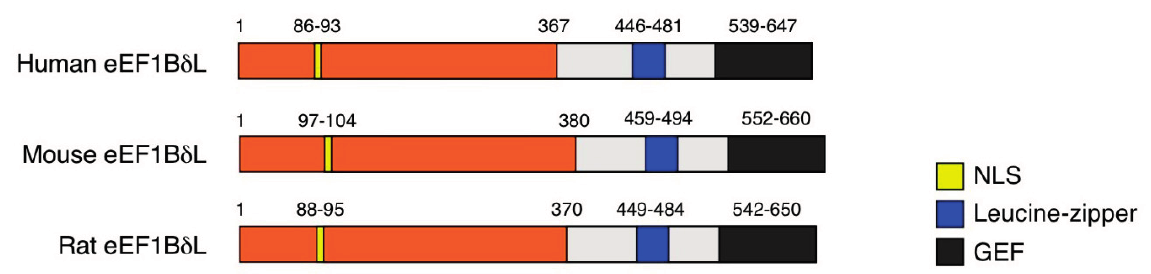
Figure 1. Schematic illustration of the EEF1D gene and protein products. Short- or long-isoform eEF1B δ mRNA is expressed, depending on whether exon III is skipped. eEF1B δ functions as a guanine nucleotide exchange factor for eEF1A and has a crucial role in translation fidelity; eEF1B δ L functions as a transcription factor for HSE-containing genes. The numbers of amino acids are shown. Asterisks indicate start or stop codons. eEF1B δ , eukaryotic elongation factor 1B δ ; eEF1B δ L, long isoform of eEF1B δ ; HSE, heat-shock element; mRNA, messenger RNA.